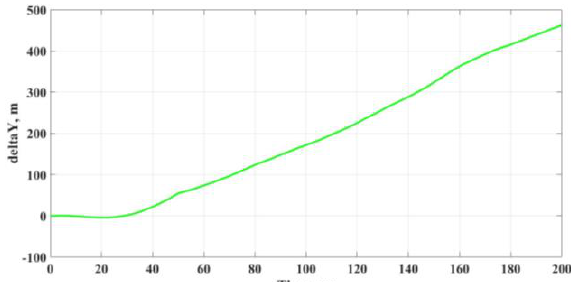
Figure 13. Changing of INS error along Y axis, including wind gust